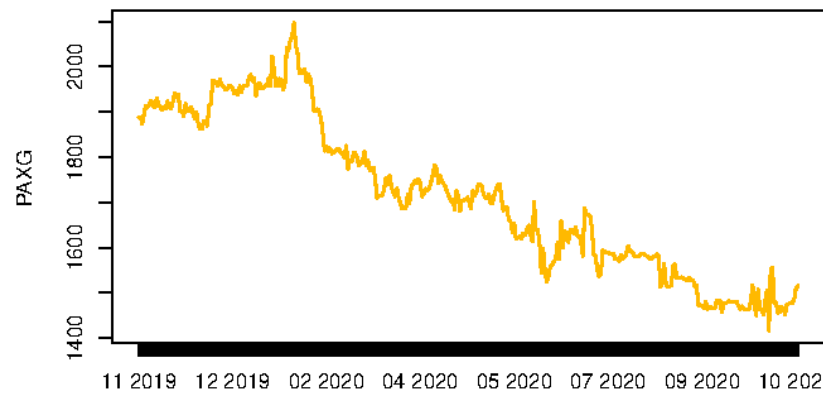
Figure 6. Price of Digix gold token (DGX)—CoinMarketCap.